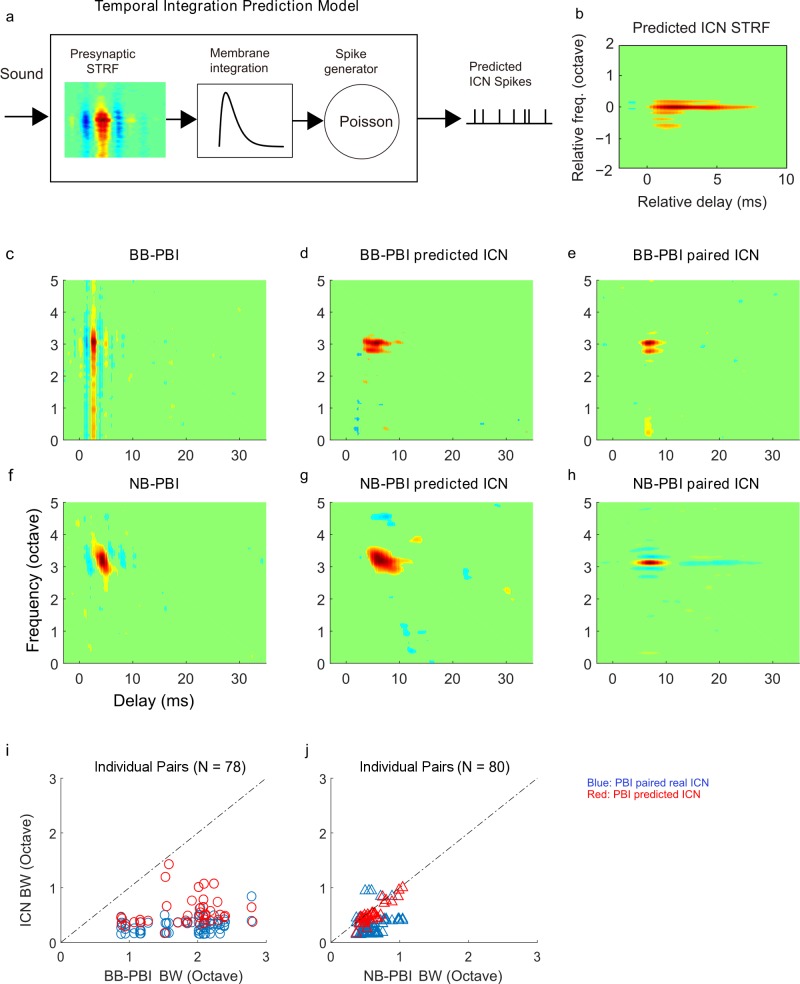
Temporal integration mechanism for sharpening frequency selectivity in ICNs.(a) A neuron model was developed to test the hypothesis that frequency selectivity can be sharpened through temporal integration of the converging broadband PBI. The model includes the PBI receptive field to account for presynaptic integration, a cell membrane integration compartment, and a Poisson spike train generator. When applied to the average broadband PBI STRF, the resulting STRF from the model spike train output sharpens dramatically and has similar spectral tuning and temporal profile (panel b) as the population-average ICN STRF (Fig 4F). (c–e) The model simulation is shown for an example broadband PBI site. The BB-PBI STRF has broad structure (panel c), whereas the predicted ICN STRF has narrowband structure (panel d) that closely mirrors the recorded ICNs (panel e). (f–h) The model simulation does not predict frequency sharpening for an NB-PBI site. The predicted ICN STRF has elongated temporal structure compared to the NB-PBI (panels f and g). However, the predicted STRF bandwidth is substantially larger than the corresponding ICNs (panel h) and comparable to that of the original PBI (panel f). Analogous to adding spike-timing jitter to individual PBI recordings (Fig 6E and 6I), the temporal integration model likewise replicates that paired bandwidth relationship for PBI and ICNs at individual sites (panels i and j). For BB-PBI sites, the model outputs have narrower bandwidths than the corresponding BB-PBI following a similar relationship to the original recordings (panel i). For NB-PBI sites, similar sharpening in frequency tuning for the model output or the recorded ICN is not observed (panel j). The measured bandwidths before and after the temporal integration model for individual narrowband PBIs were significantly correlated (r = 0.89 ± 0.03, mean ± SE; p < 0.01), implying that the bandwidth after adding spike-timing jitter was inherited from the original narrowband PBI. Underlying data can be found in S8 Data and S8 Code. BB, broadband; ICN, inferior colliculus neuron; NB, narrowband; PBI, putative brainstem input; STRF, spectrotemporal receptive field.